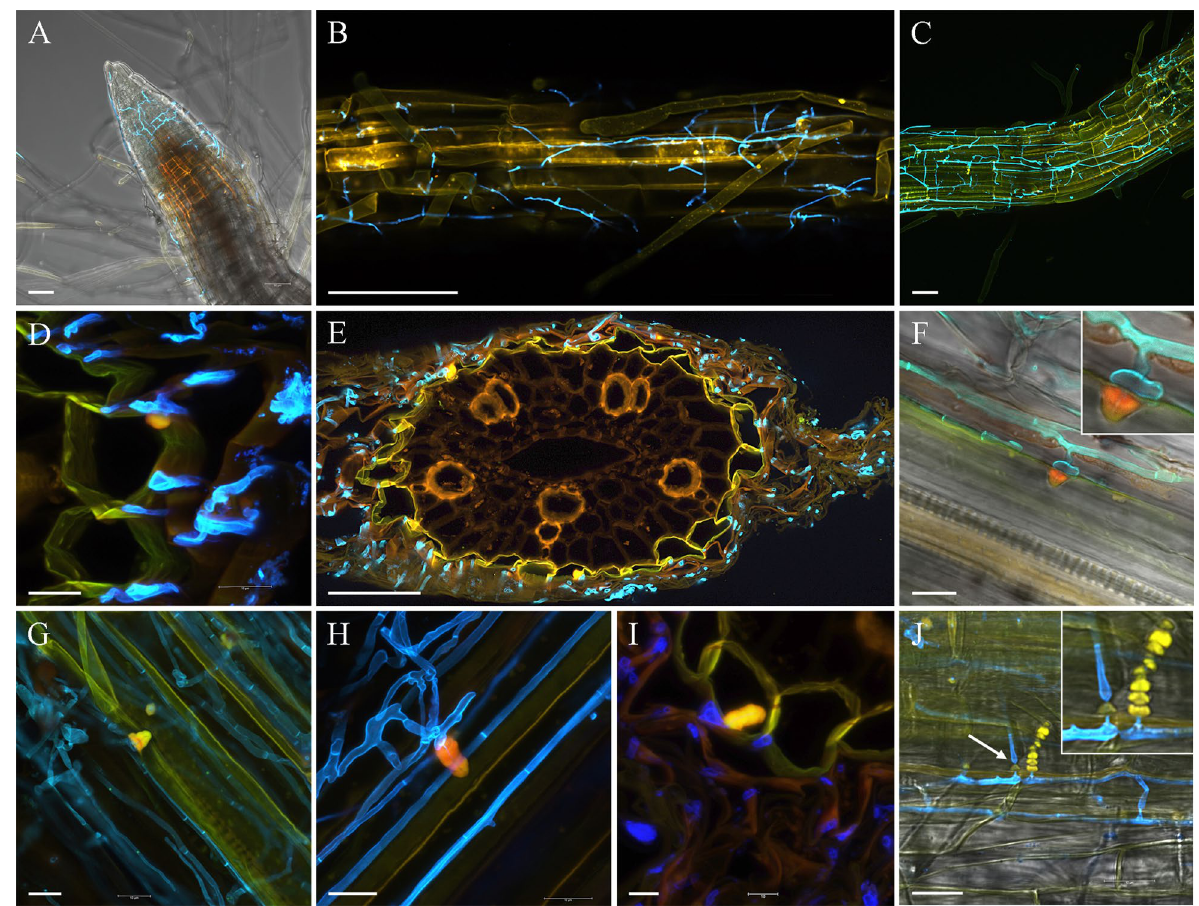
Fig. 6 Confocal laser scanning micrographs of fungus–plant cell interaction between Polydomus karssenii strain DSM 106825 and wheat. Wheat seedlings (1 week old) were inoculated with mycelium plugs and infection monitored 8–9 weeks thereafter. Infected plant roots were treated with aniline blue diammonium salt to stain fungal and plant cell wall “β‑glucans" (overlay of stain and autofluorescence of cytoplasm depicted in yellow, or orange pseudo colours, respectively) and wheat germ agglutinin‑Alexa Fluor 488 (WGA‑AF488) to stain fungal chitin (blue/turquoise pseudo colour). a – c General view of root apex showing fungal colonisation. d Transverse section of root showing intercellular colonisation of root cells by strain DSM 106825. e Transverse section of vascular cylinder (stele) showing that the fungus colonised cortex and endodermal cells but not the vascular tissues. f Longitudinal section showing hyphal swelling, resembling an appressorium, and formation of a penetration peg surrounded by a callosic papilla‑like structure. g , h Longitudinal section showing the development of callosic papilla‑like structures surrounding hyphal penetration pegs. i Transverse section showing intercellular colonisation of the fungus and formation of callostic papilla‑like structures associated with the fungal colonisation of plant cells. j Longitudinal section indicating the growth of a hypha by passing through callosic tissues (papillae like structures). Bars 50 µm ( a–c ), 10 µm ( d–j =